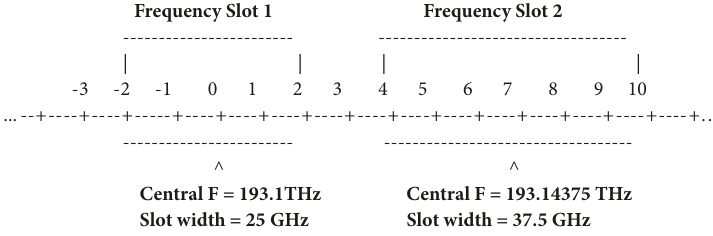
Figure 4: Frequency Slot example from the flexi-grid optical network standard